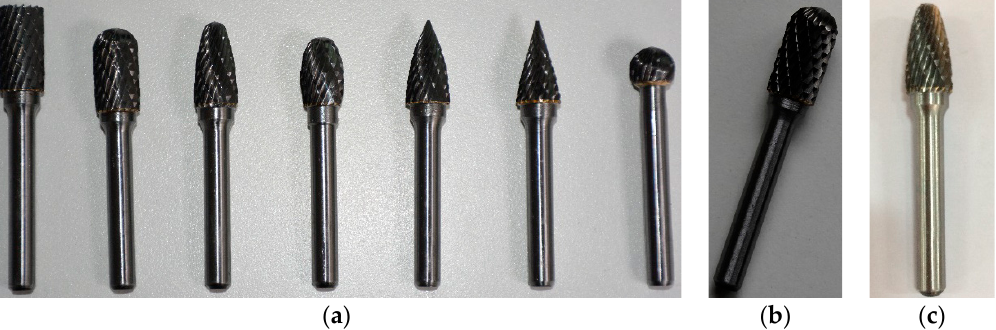
Figure 12. Carbide rotary tools: ( a ) series of tools; ( b ) cylindrical ball nose tool; ( c ) arch ball nose tool.